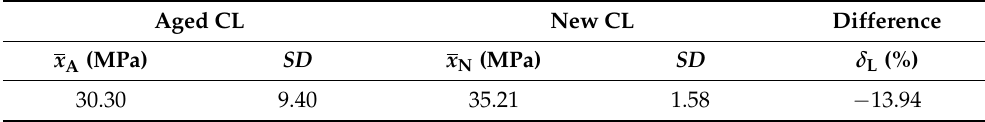
Table 4. Parallel-to-grain compressive strength of the logs f c,0,log